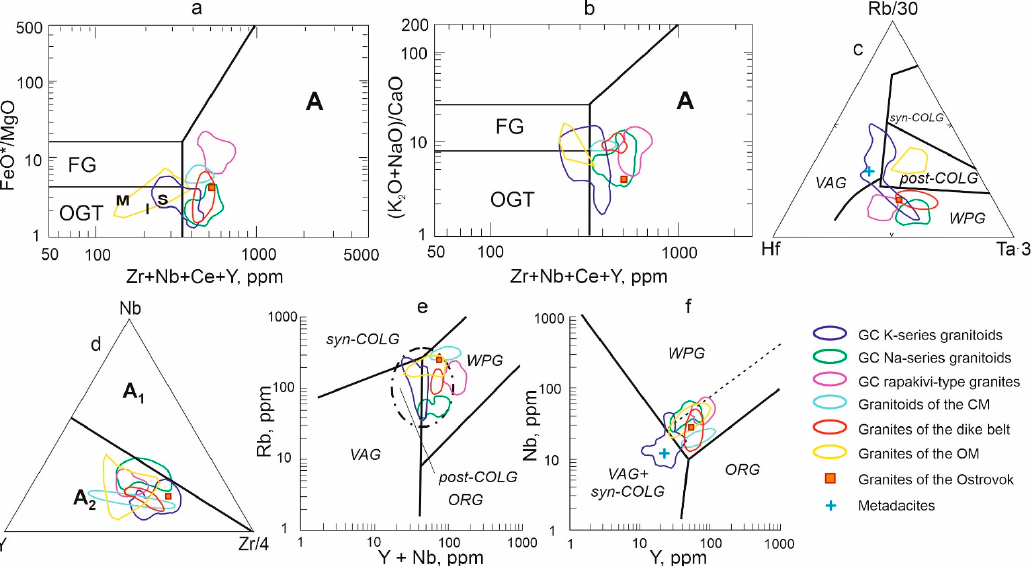
Figure 34. Discrimination plots for major rock associations of the GC: ( a ) FeO*/MgO vs. Zr + Nb + Ce + Y, ( b ) (K 2 O + Na 2 O/CaO vs. Zr + Nb + Ce + Y, ( c ) Rb–Hf–Ta, ( d ) Nb–Y–Zr, ( e ) Rb–(Y + Nb), and